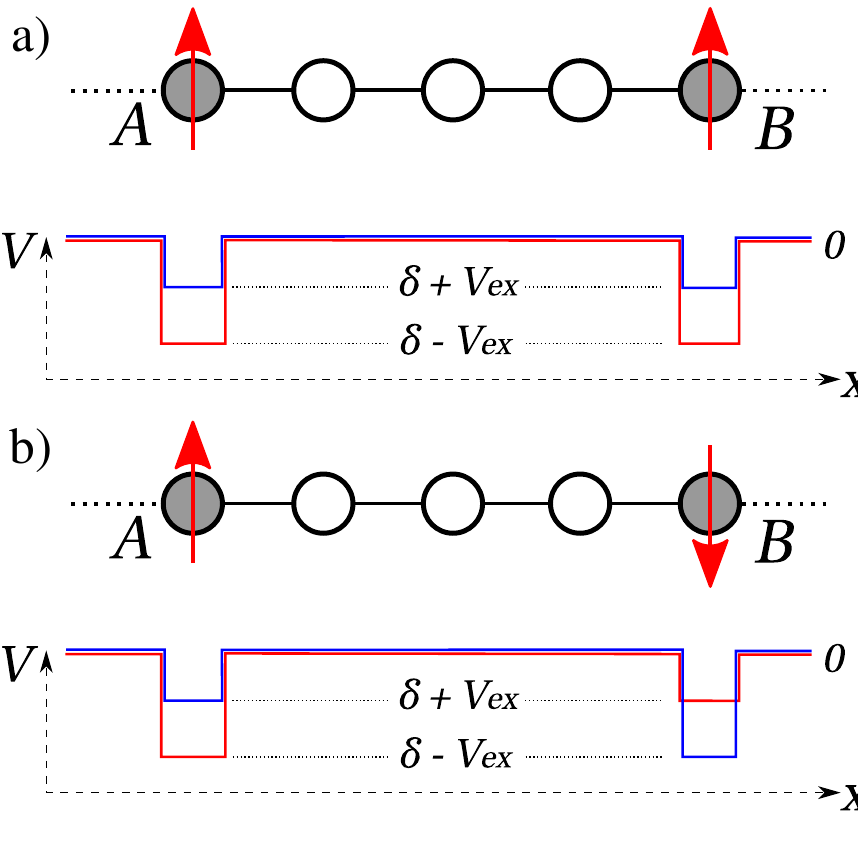
Figure 2. Schematic representation of the spin-split potentials at the magnetic sites for the parallel ( a ) and antiparallel ( b ) alignments of the magnetic moments. The red (blue) curves show the potential experienced by up-spin (down-spin) electrons as a function of position. For simplicity the host medium is represented by a one-dimensional linear